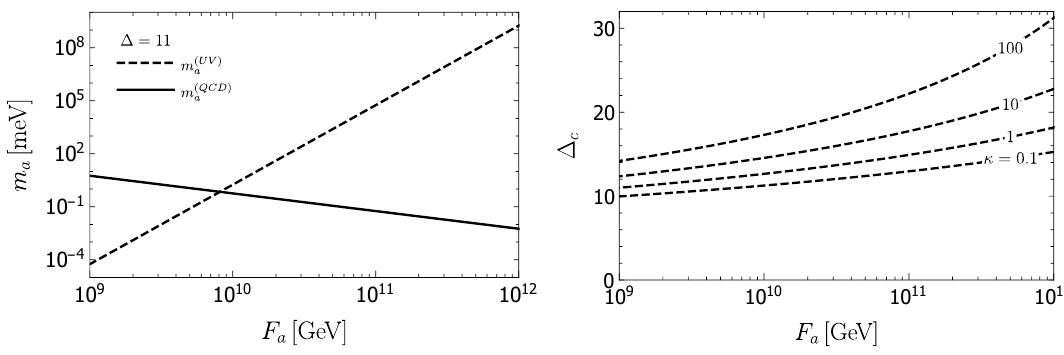
Figure 5 . Left panel: QCD (solid) and UV (dashed) contributions to the axion mass for (cid:1) = 11 and (cid:20) = 1. Right panel: critical operator dimension, (cid:1) c , needed to solve the axion quality problem. We (cid:12)xed k = M P , kz UV = 1, (cid:27) 0 = 0 : 1, ‘ UV = 0 : 1, and b UV =